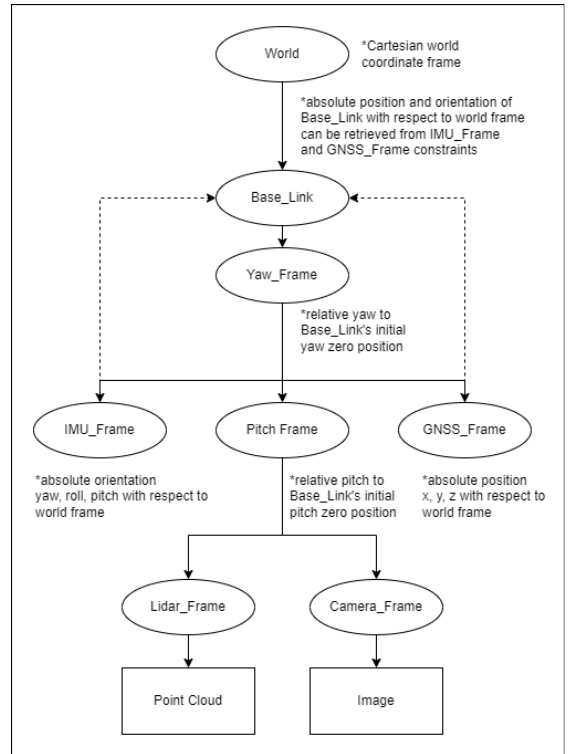
Figure 4. TF2 coordinate frames with relation